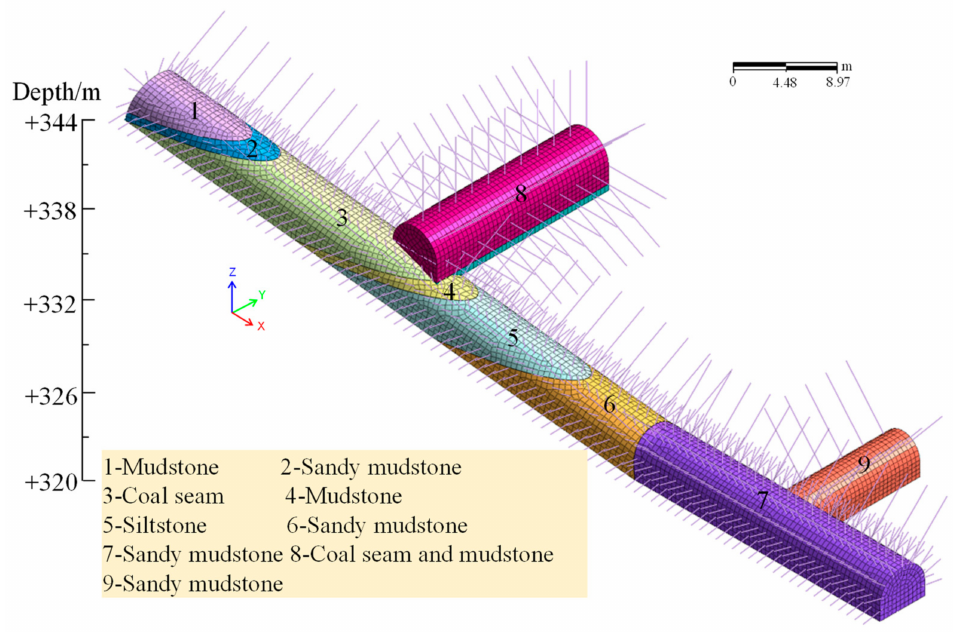
Figure 5. Supporting model of shaft, roadway and chamber in practical